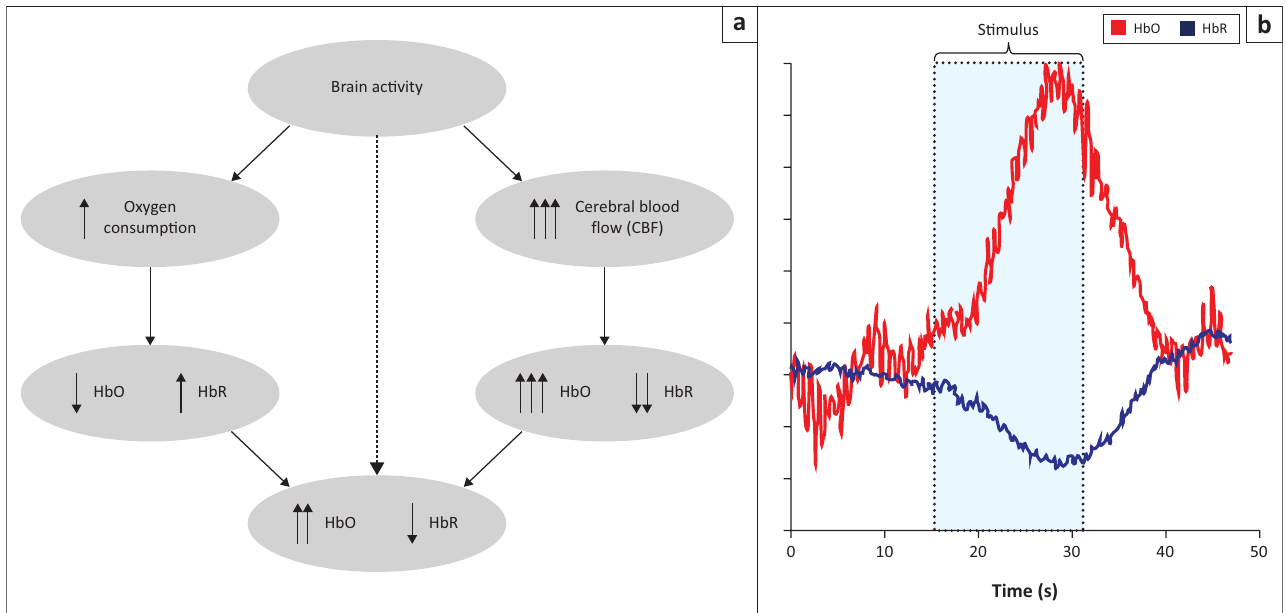
FIGURE 1: Illustration of the neurovascular couple concept. (a) A schema depicting the haemodynamic changes related to brain activity metabolism. The up and down arrows represent increase and decrease, respectively. HbO stands for oxygenated haemoglobin; and HbR for deoxygenated haemoglobin. (b) Brain haemodynamic response to a stimulus. The traced rectangle represents the stimulus period (e.g. the time spent by a participant to perform a cognitive task such as solving a mathematical problem). Once the stimulus or task starts, an increase of the oxygenated haemoglobin (HbO) and a decrease of the deoxygenated haemoglobin (HbR) occur and reach a peak. After the stimulus period, the HbO and HbR concentrations tend to return to the initial values before the stimulus (basal